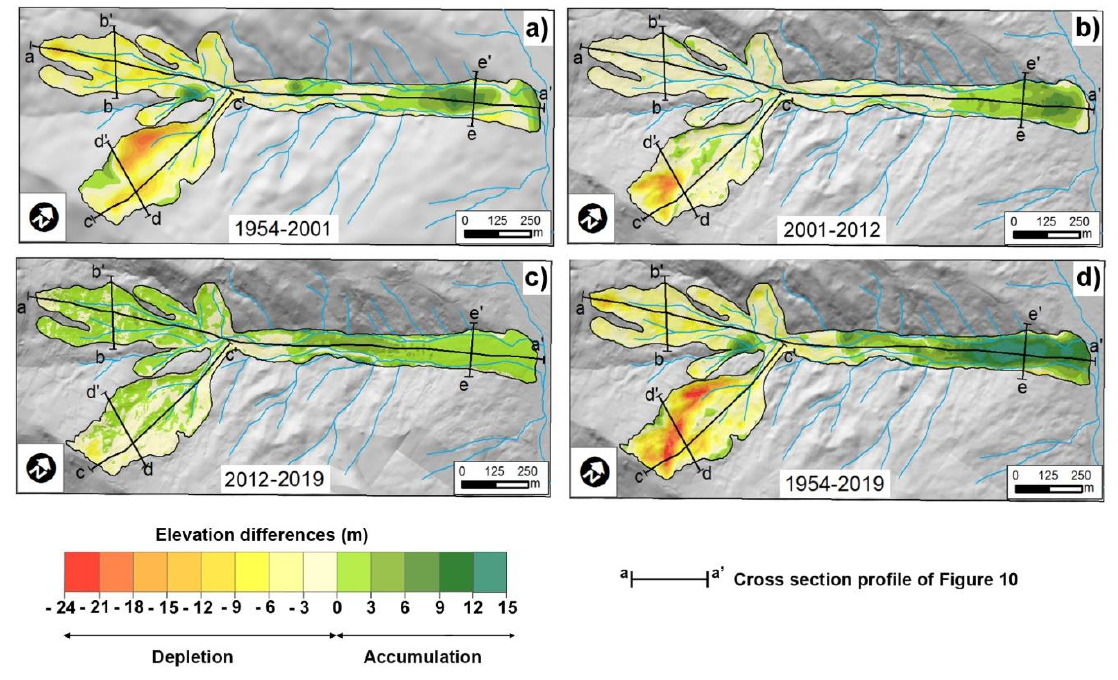
Figure 9. Maps of the elevation differences of the Vomice earthflow computed by the comparison of DEMs in the period: Table 5. Elevation differences between 1954, 2001, 2012, and 2019 DEMs.